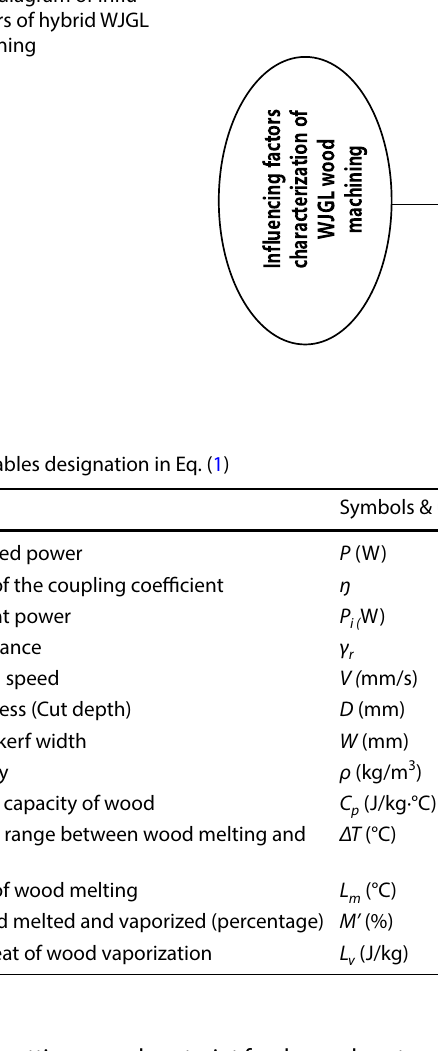
Fig. 4 Block diagram of influ- encing factors of hybrid WJGL wood machining